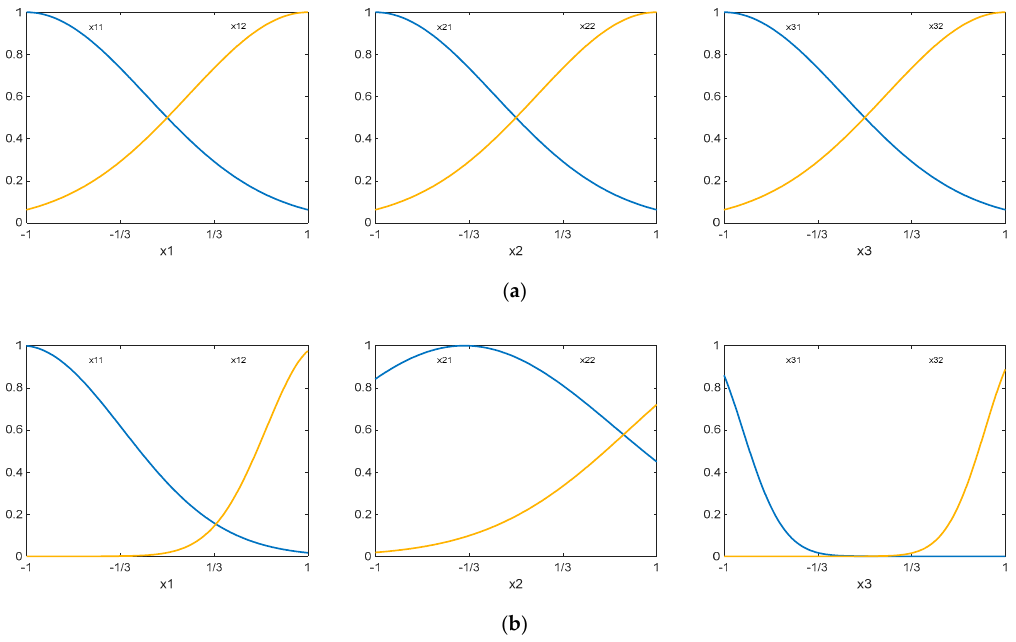
Figure 22. Membership functions for modeling type 2 function ( f 2 ) ( a ) before the ANFIS and ( b ) after the ANFIS.